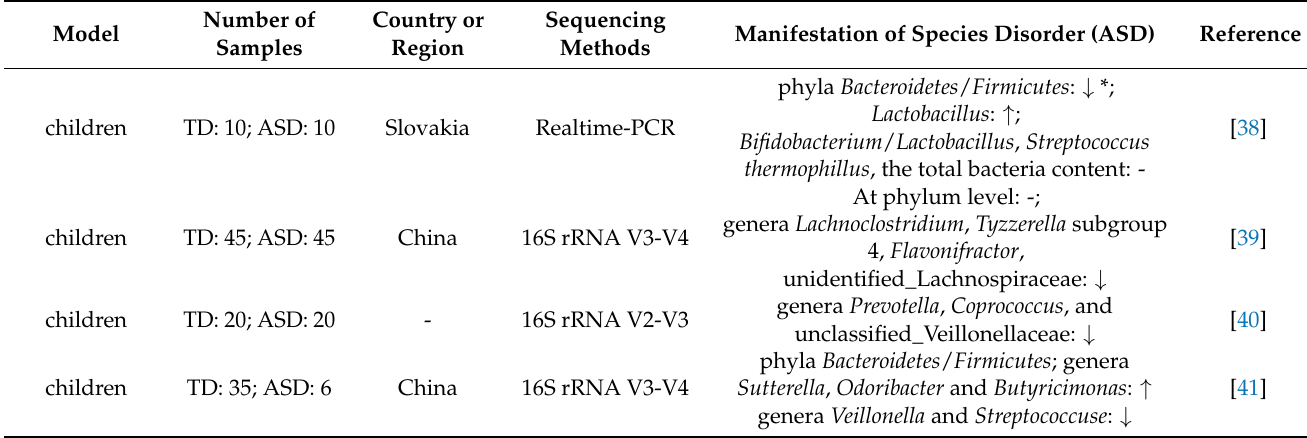
Table 1. Findings of previous studies. Differences in gut microbiota between individuals with autism spectrum disorder (ASD group) and typically developed individuals (TD